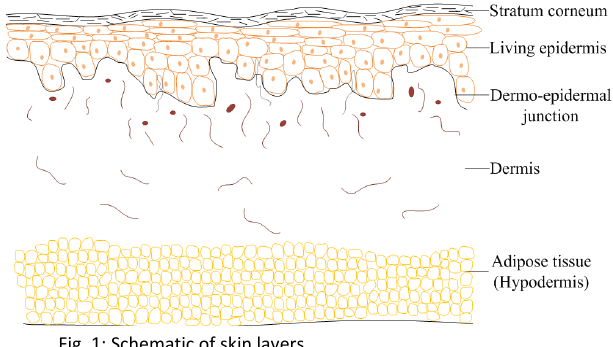
Fig. 1: Schematic of skin